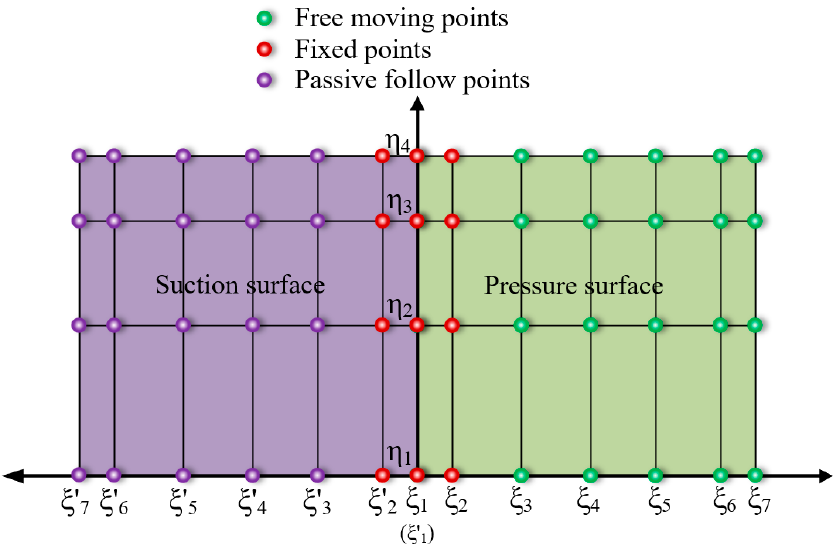
Figure 7. Distribution of the parameterised control vertexes. Table 4. Range of variation of each control vertexes.